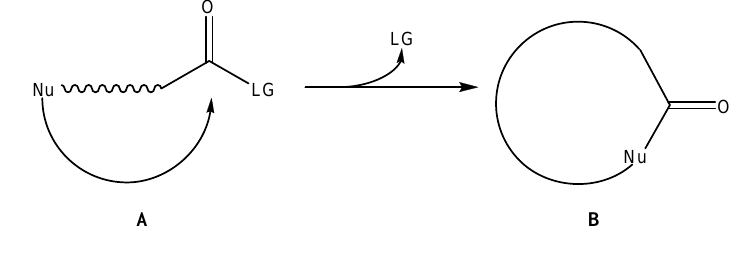
Scheme 1. Intramolecular cyclization-elimination reaction for activation of a general prodrug A.